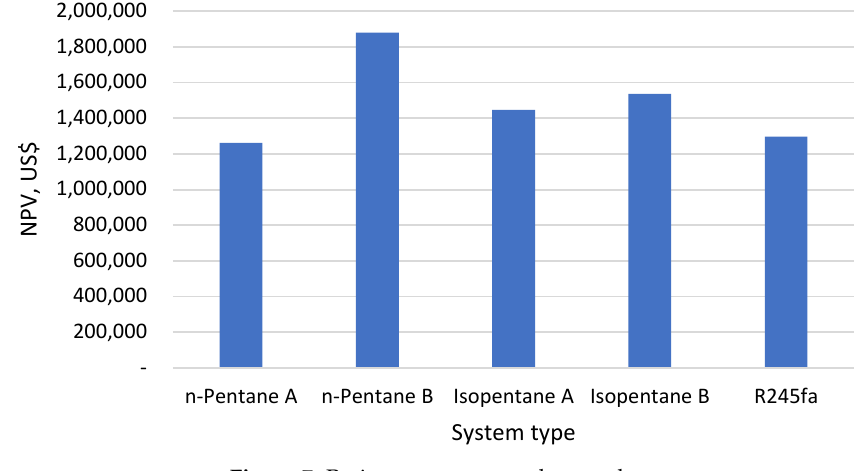
Figure 7. Project net present value results.